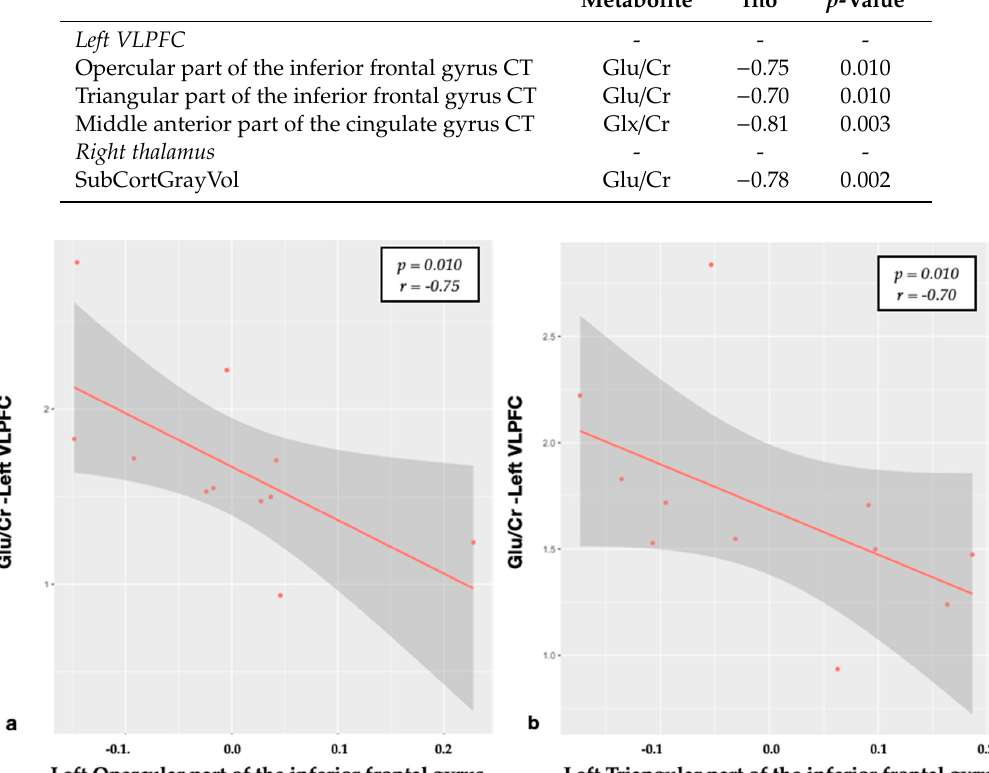
Figure 2. The Spearman’s correlation of Glu/Cr in the left VLPFC and cortical thickness of the opercular ( a ) and triangular ( b ) parts of the left inferior frontal gyrus (residuals). Thalamic regions: a significant negative relationship was found between the Glu/Cr levels in the right thalamus with the subcortical GM volume ( p = 0.002; r = − 0.78) (Figure 3).